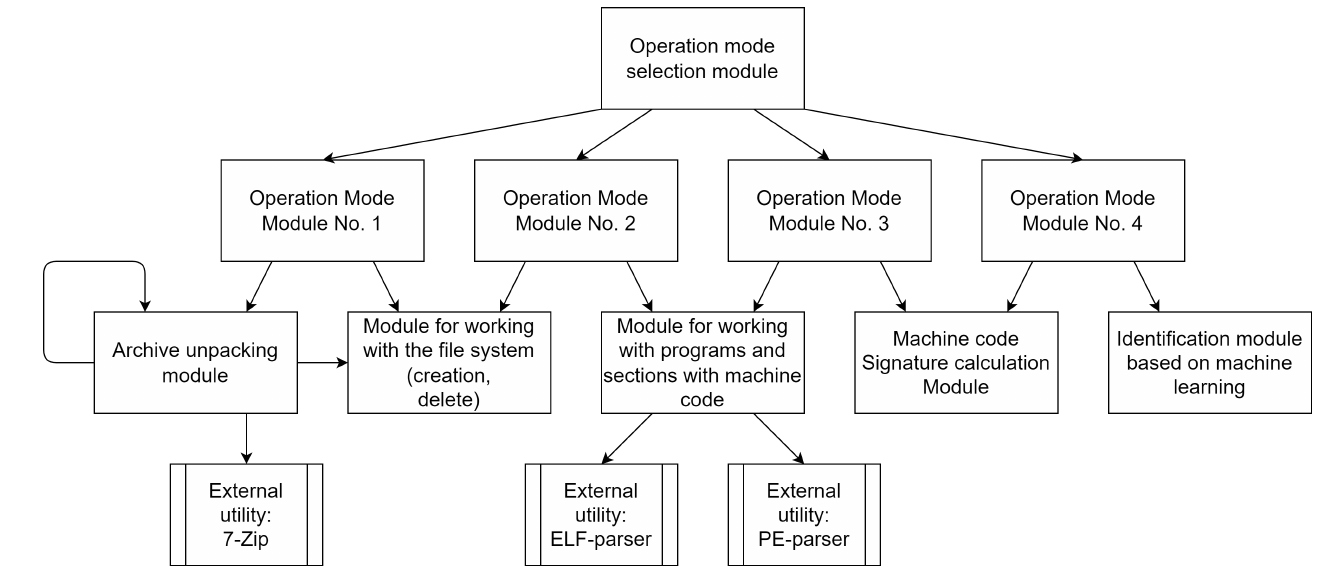
Figure 4. Functional layer of identification utility